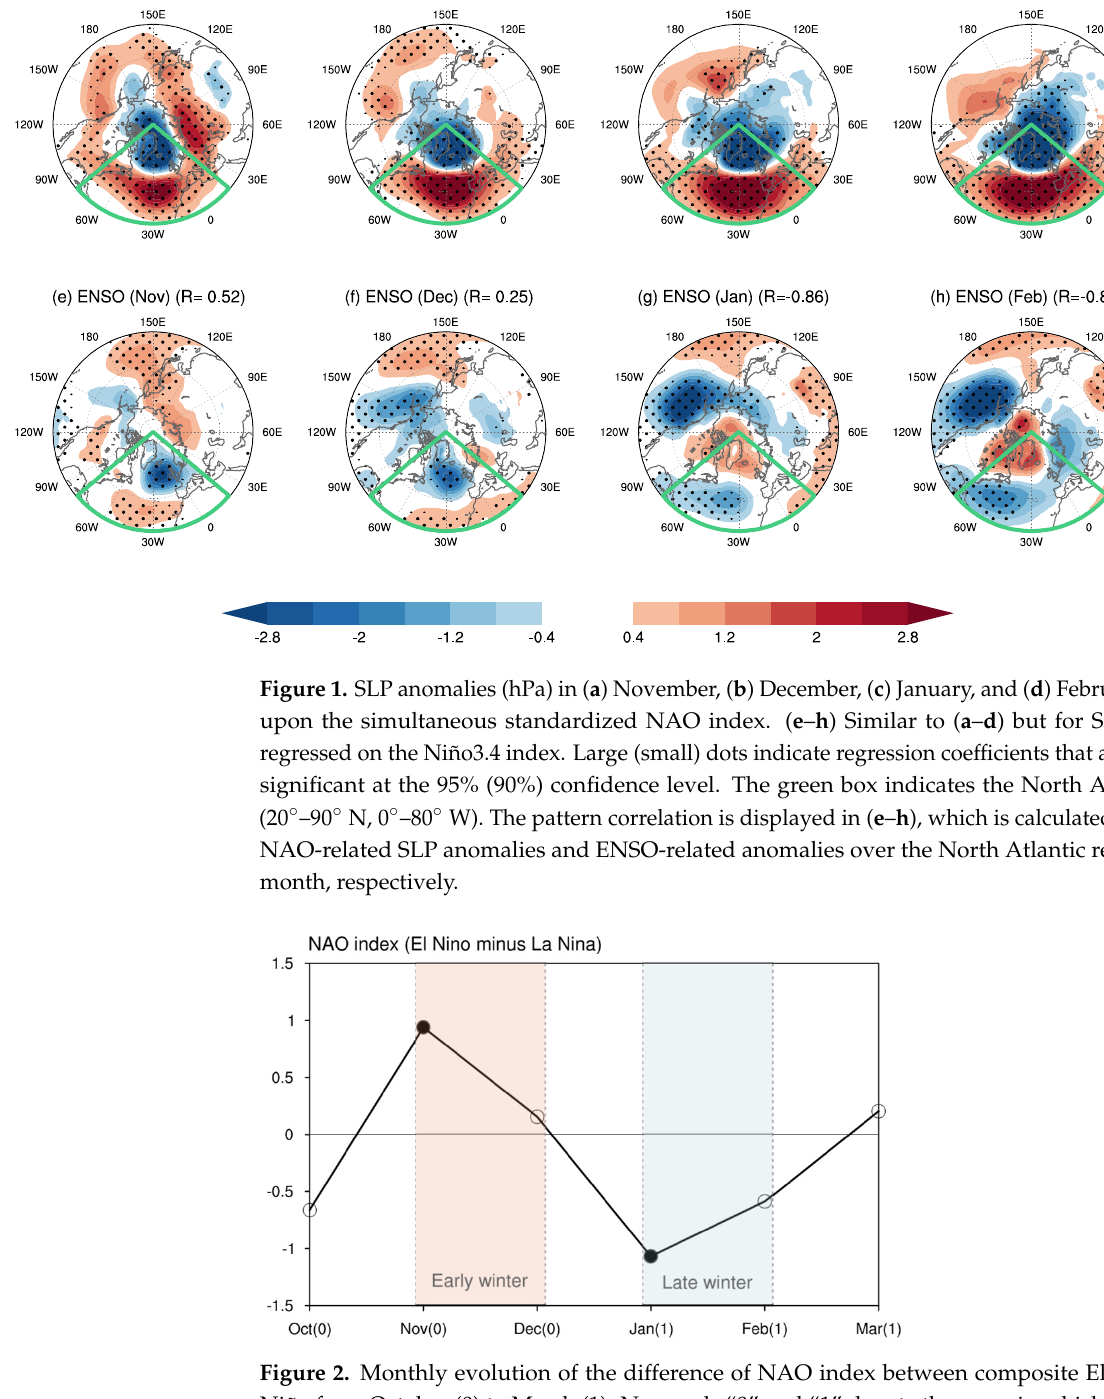
Figure 2. Monthly evolution of the difference of NAO index between composite El Niño and La Niña from October (0) to March (1). Numerals “0” and “1” denote the years in which ENSO events develop and decay, respectively. Solid circles indicate the composite values that are significant at the 95% confidence level. The orange and blue shadings indicate the early and late winter,